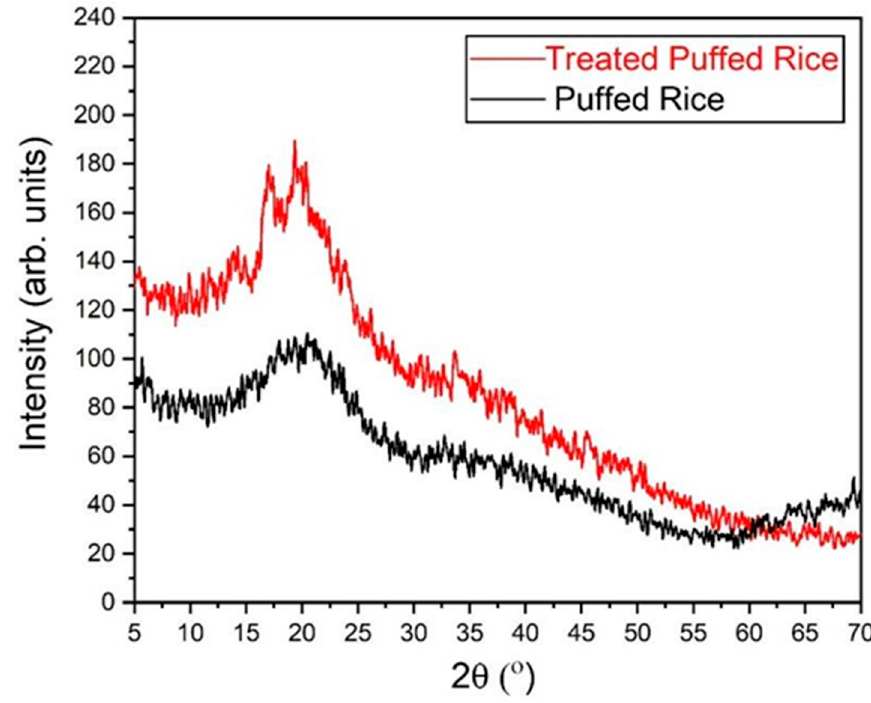
Figure 8. X-ray diffraction patterns of fresh puffed rice and treated puffed rice.